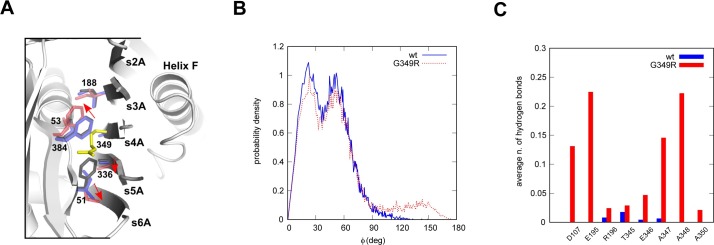
Comparative structural analysis and molecular dynamics simulations suggest an impaired presentation and insertion of the RCL.(A) Residues in the vicinity of position 349 (yellow) following loop insertion are shown as sticks for cleaved wild-type alpha-1-antichymotrypsin (PDB: 2ACH, purple), the A349R variant (PDB: 1AS4, red) and AAT (PDB: 1EZX, black). Red arrows show the compensatory side-chain movements that occur in alpha-1-antichymotrypsin to accommodate the bulky charged arginine residue. The figure was prepared using PyMol. (B) Probability distribution of the angle φ defined in the text, as calculated in MD simulations for the wild type (solid line) and the G349R variant (dashed line). (C) Average number of hydrogen bonds between residue 349 and selected residues calculated in the MD simulations, for the wild-type AAT (wt, black) and the Iners variant (G349R, grey).